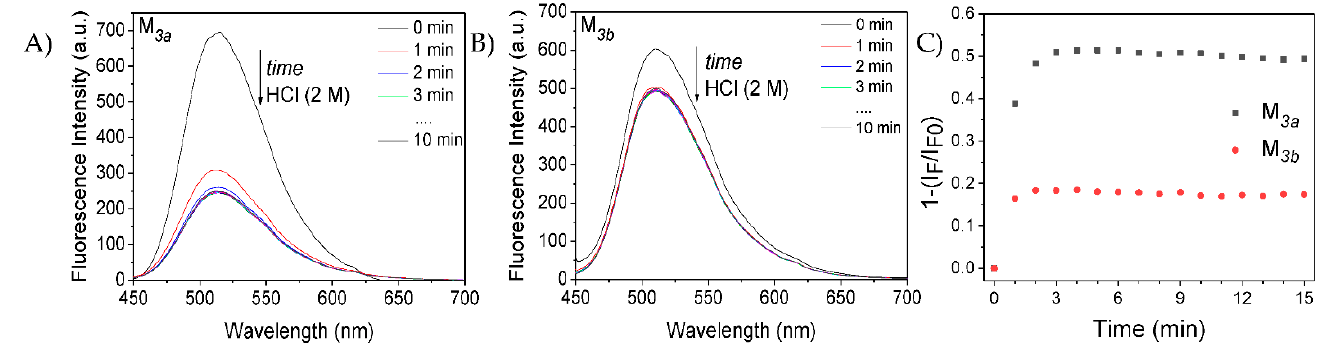
Figure 5. Fluorescence spectra of the functionalized membranes M 3a ( A ) and M 3b ( B ) and Time response ( C ) to pH.